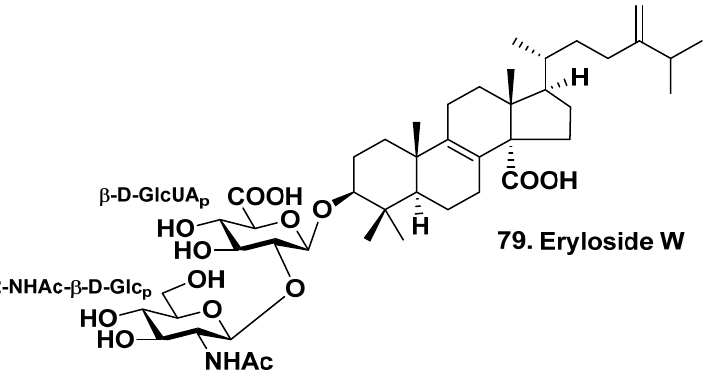
Figure 8. Eryloside W ( 79 ) from Dictyonella marsilii .